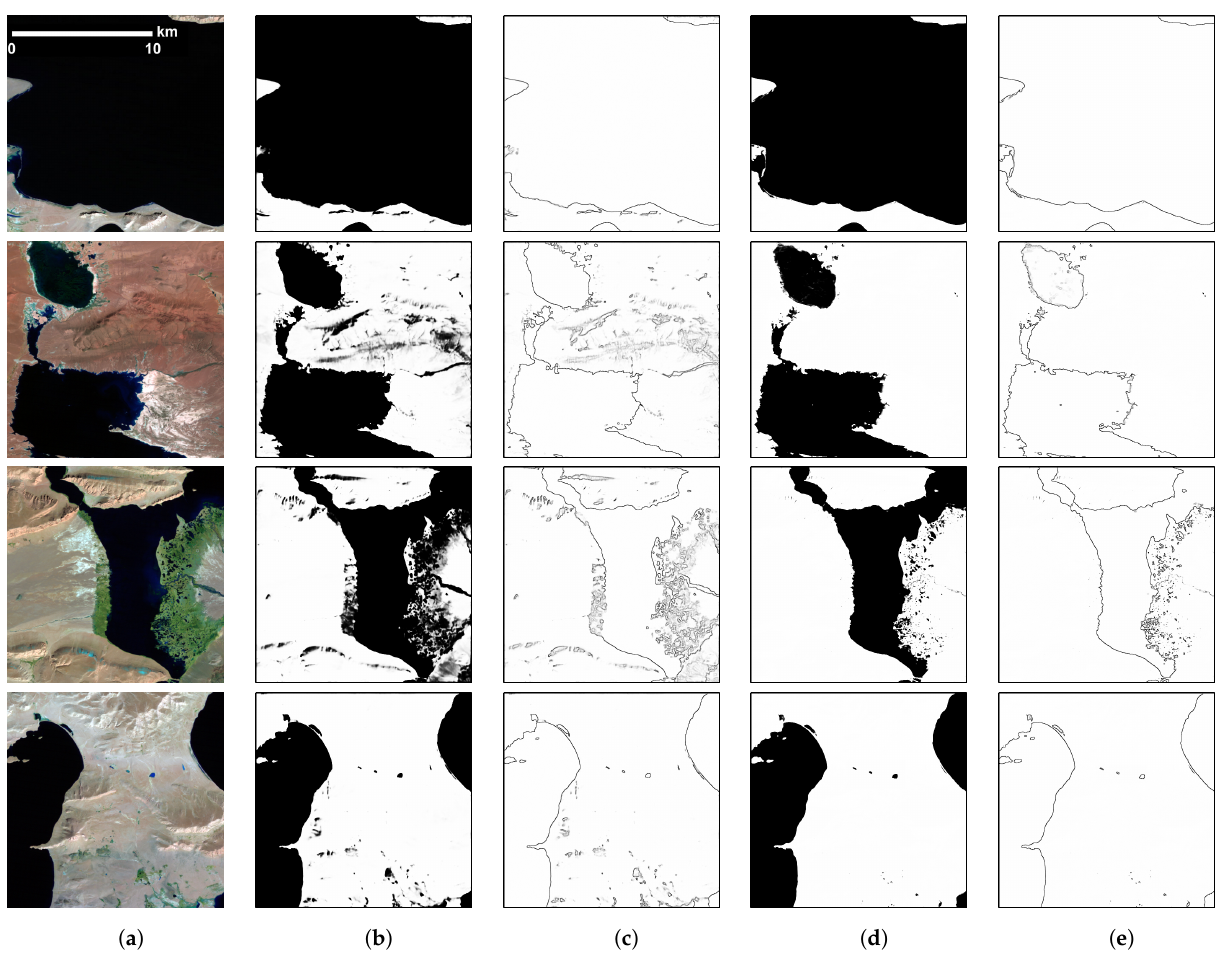
Figure 8. Four examples (row 1–4) of lake area and shoreline of lake Selenco from Lansat-5 images by using LaeNet model with different training images as input. ( a ) indicate the pseudo color images by using band 4, 4, 5 as the RGB channel; ( b , c ) are test results of lake area and shoreline by using Landsat-8 for training; test results of lake area and shoreline by using Landsat-5 images for training is indicated in ( d , e ),